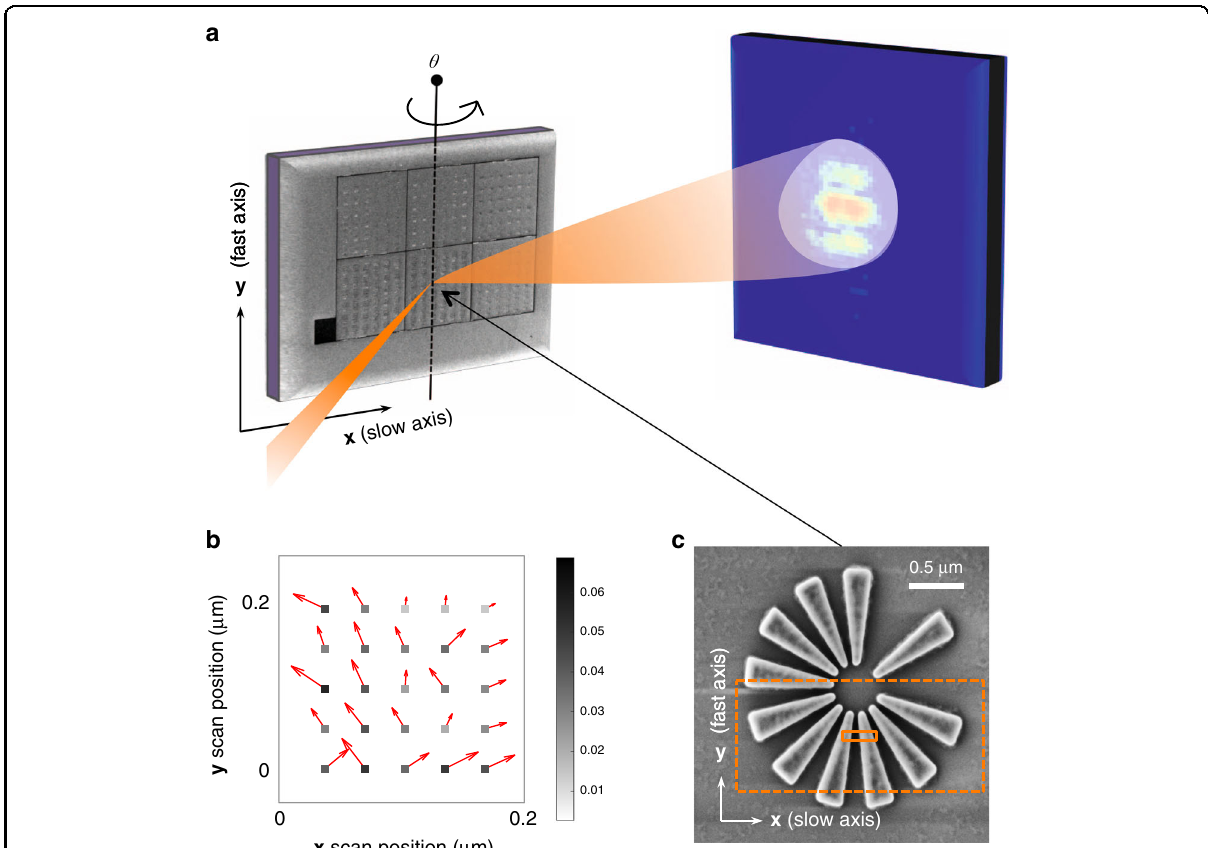
Fig. 1 Bragg ptychography experiment. a Data acquisition scheme, showing the sample in Bragg condition, illuminated by a focused beam and producing a coherent diffraction pattern, measured by a 2D detector. For the Bragg ptychography data acquisition, the sample is scanned along the x - and y -axis and further angularly scanned along the θ rotation. b For this experiment, the scanning stage was not optimized and a strong discrepancy was observed between the nominal x and y position (square) and the achieved positions (indicated by the red arrows and by the color scale, in μ m). c SEM picture of the investigated Si-star sample (top view). The orange rectangles represent the footprint of the intensity central lobe (FWHM) on the sample surface (continuous line) and the full dimension of the retrieved probe, including its tails (dashed